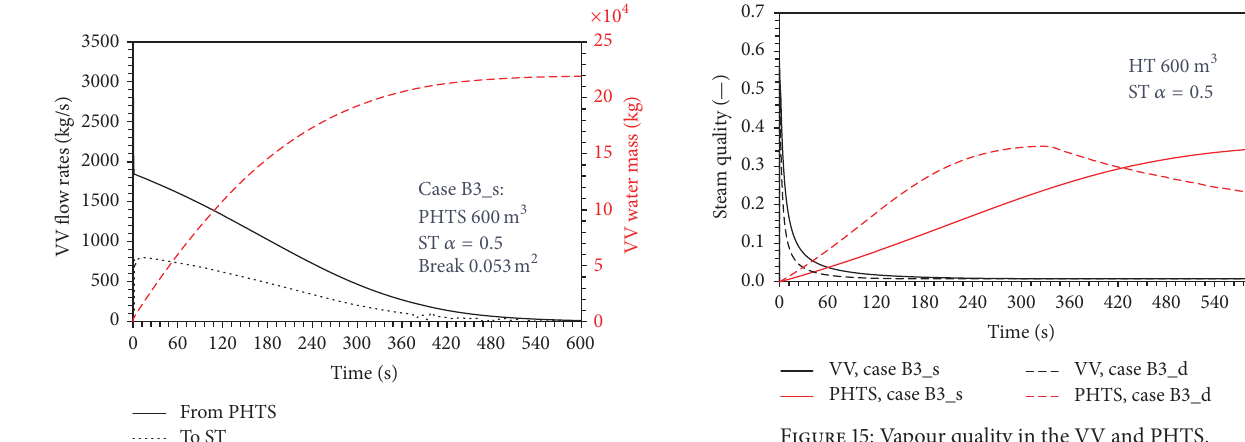
Figure 15: Vapour quality in the VV and